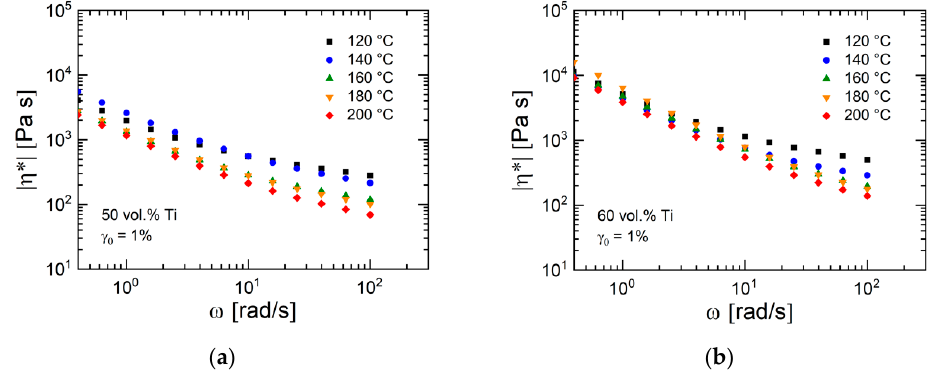
Figure 11. Magnitude of complex viscosity η * for the feedstocks with ( a ) 50 and ( b ) 60 vol.% Ti particles as a function of angular frequency ω at five temperatures. The shear amplitude γ 0 was 1%.